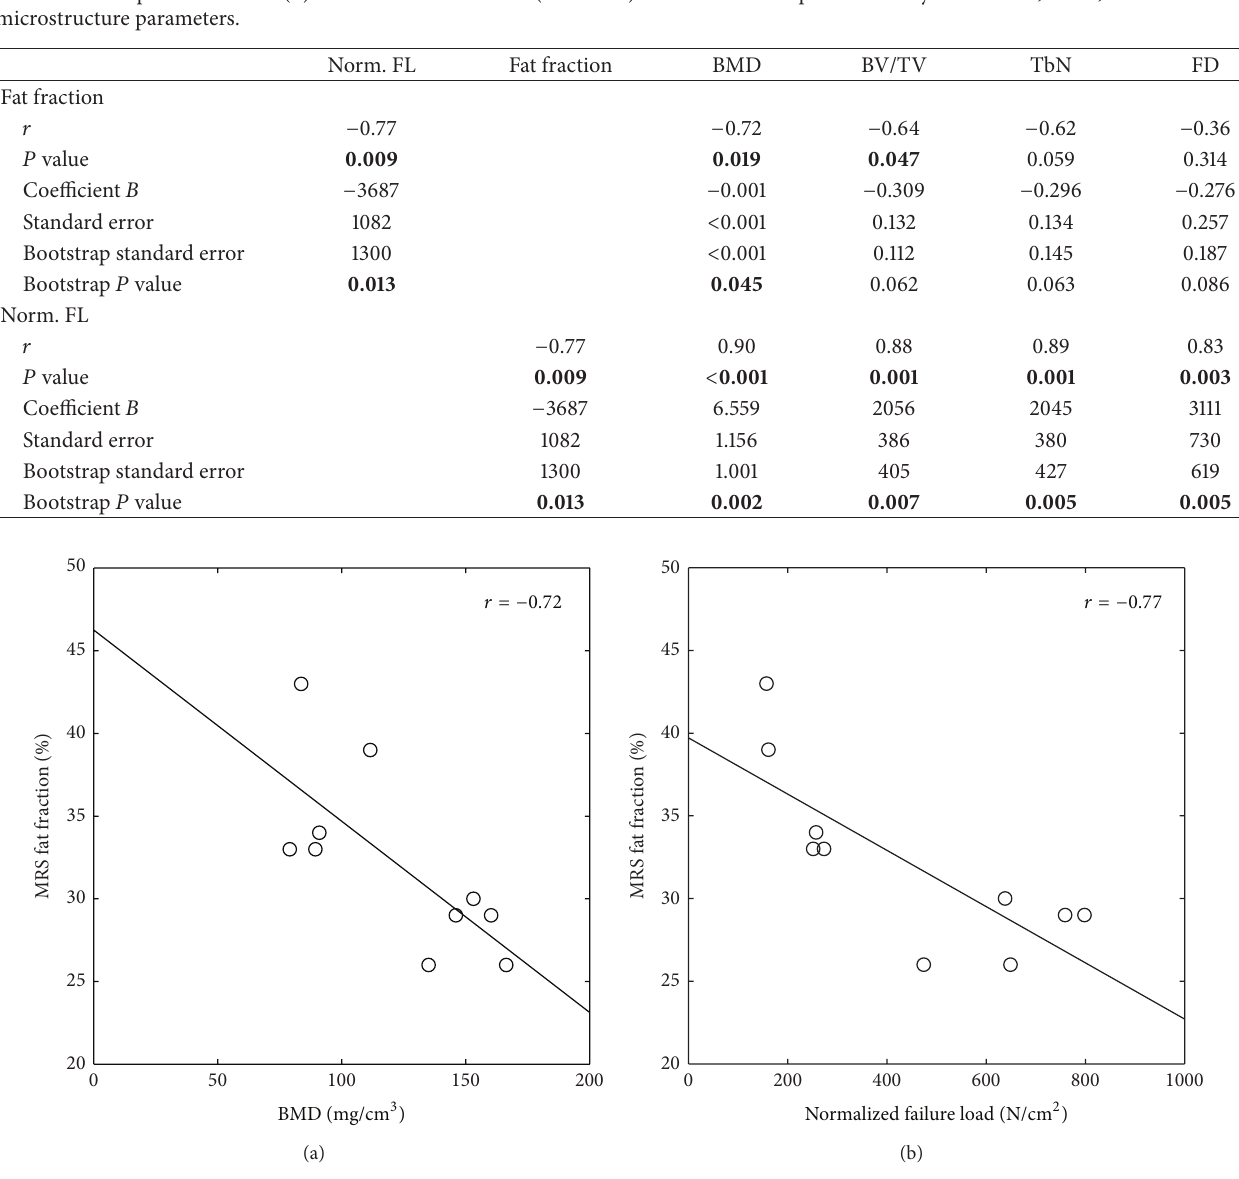
Figure 2: Relationship (a) between MRS proton density fat fraction and BMD and (b) between MRS proton density fat fraction and normalized failure load. The open circles represent the experimental results and the solid line shows the result of the linear